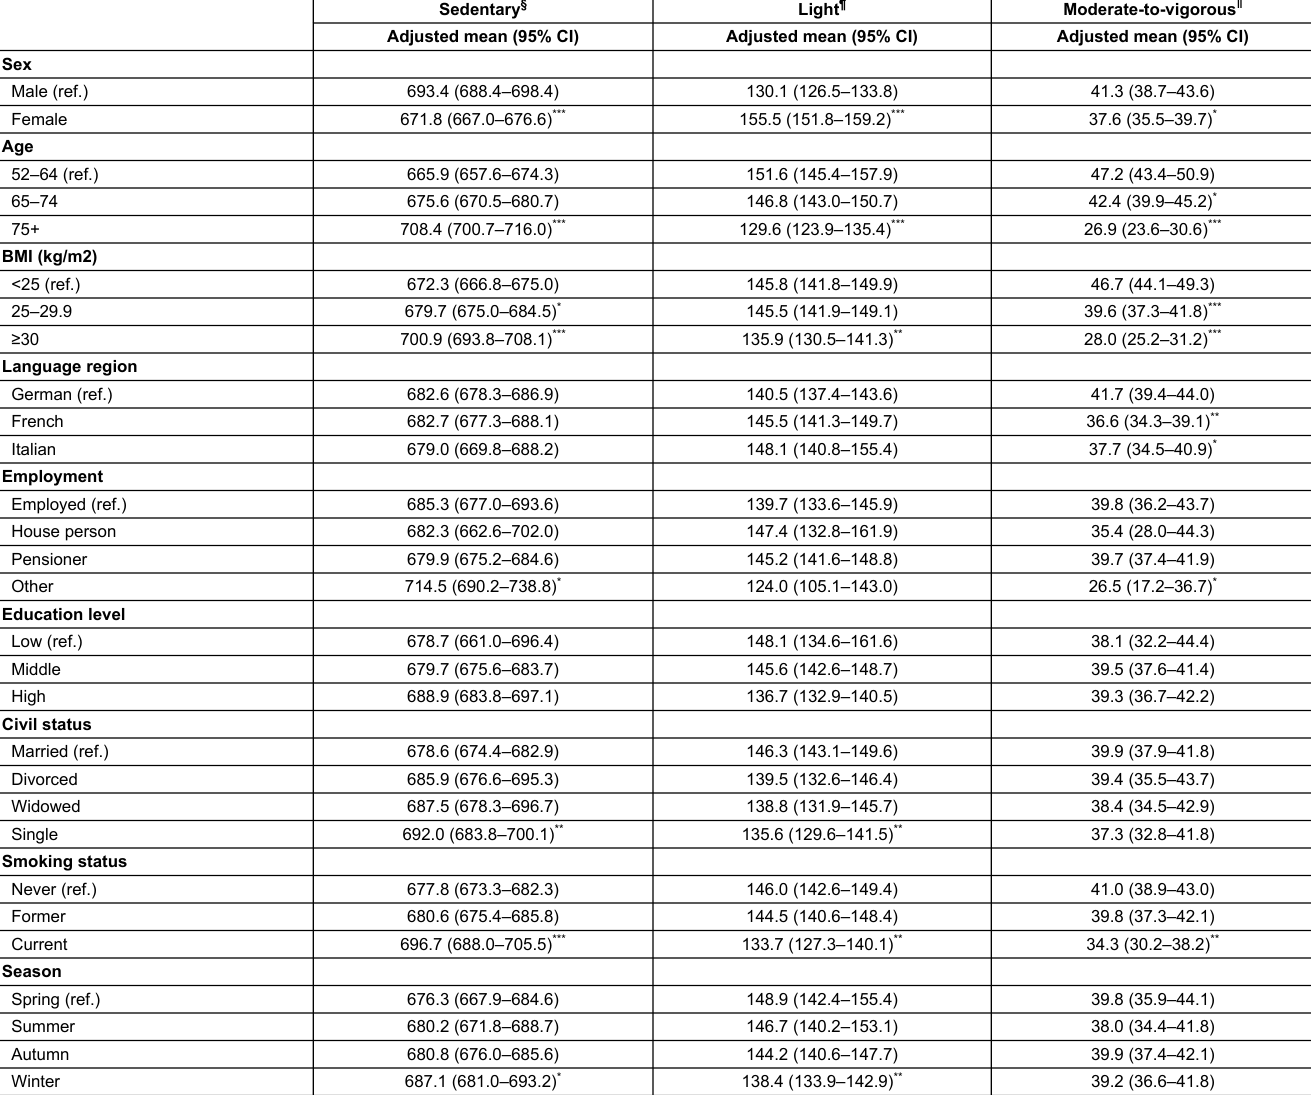
Table 3: Mutually adjusted mean minutes per day † spent in specific levels of physical activity intensity (n = 1314), according to patient characteristics ‡ . Sedentary